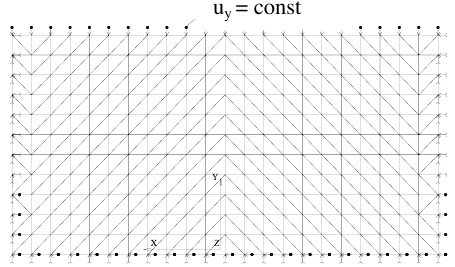
Fig 3 . Finite elements representation of the sample during the shear box